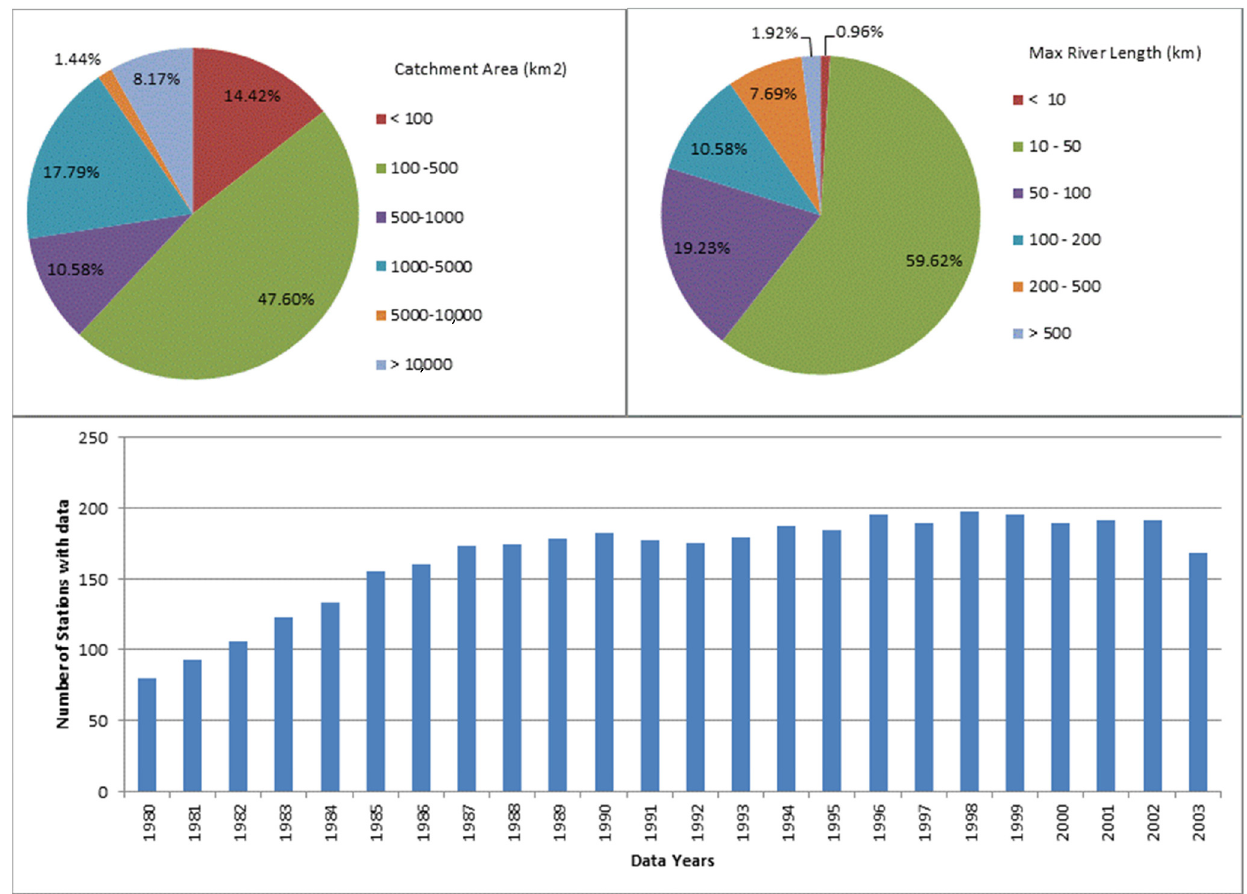
Figure 1. Summary statistics of catchment area, river length, and gauging stations used in this